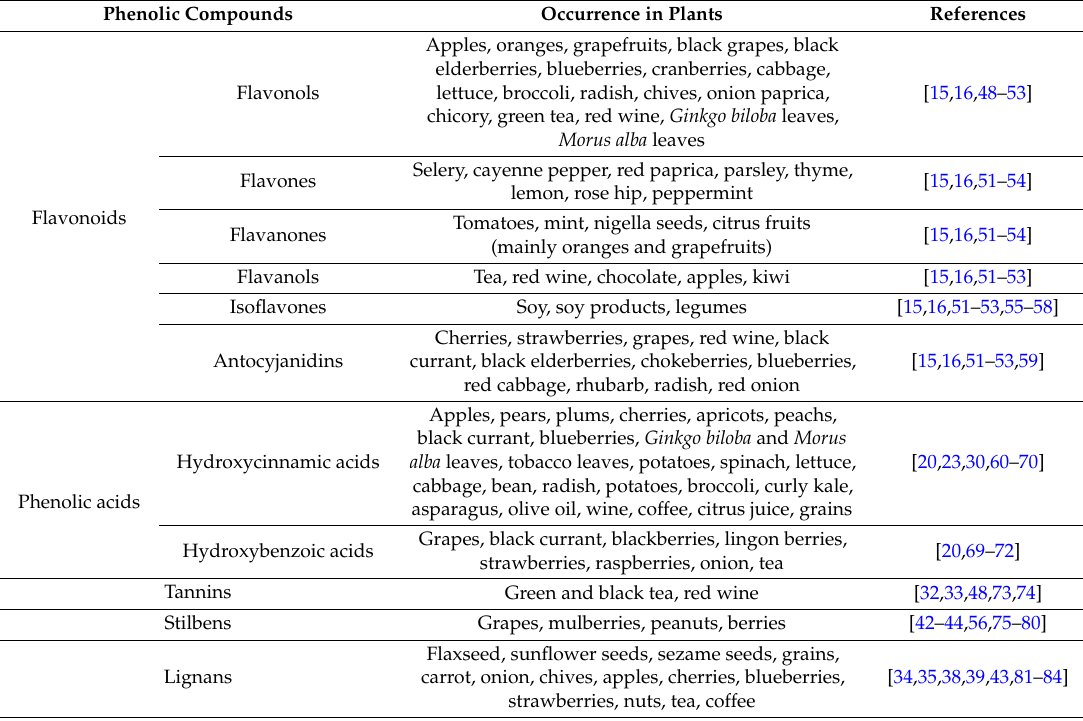
Table 1. The occurrence of phenolic compounds in predominantly edible plants and plant-derived products. Phenolic Compounds Occurrence in